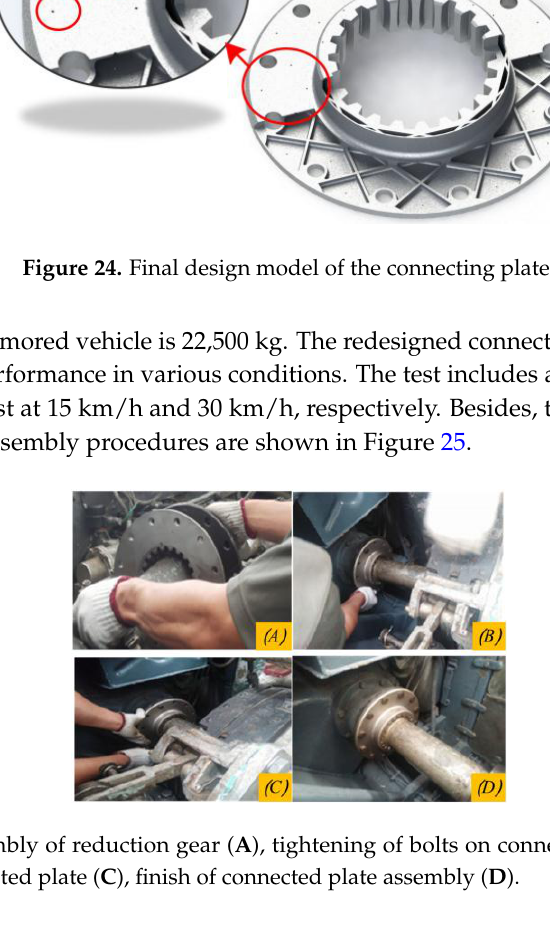
Figure 23. Stress distribution of original connecting plate ( a ), deformation of original connecting plate ( b ), stress distribution of redesigned connecting plate ( c ), deformation of redesigned connecting plate ( d ).